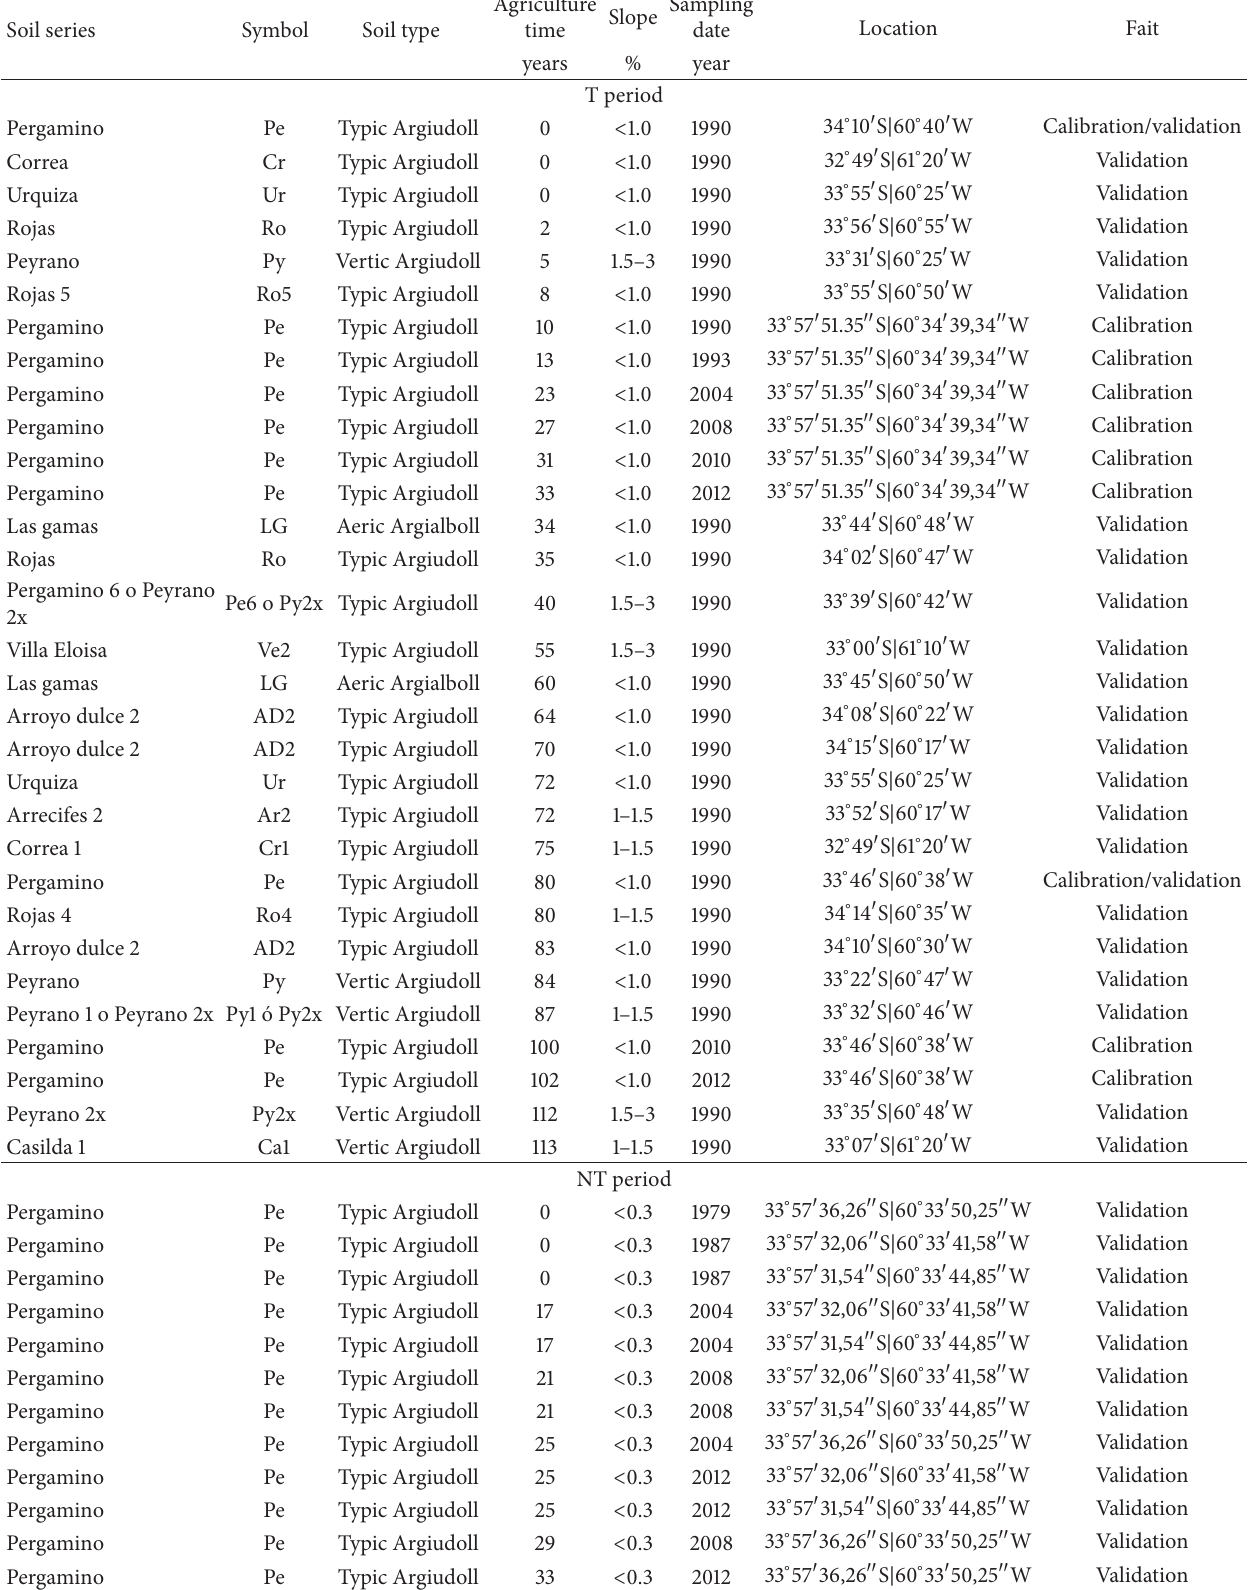
Table 1: Description of study sites used for the validation model during T and NT